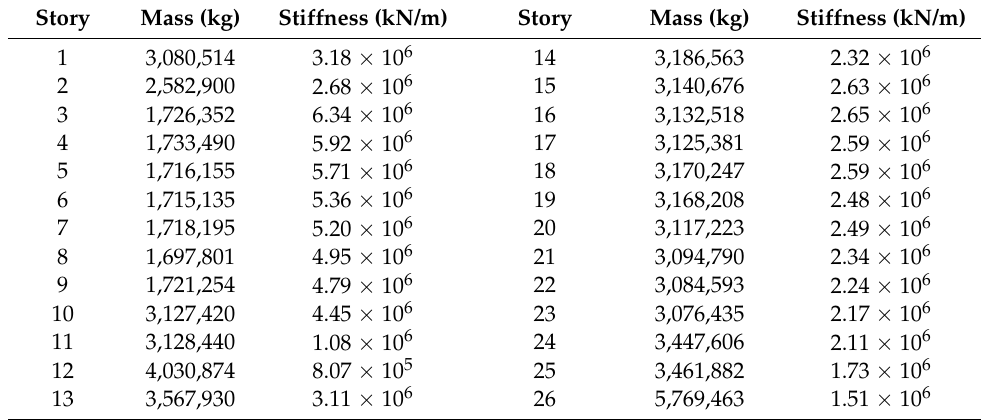
Table 1. Story mass and stiffness of the sample